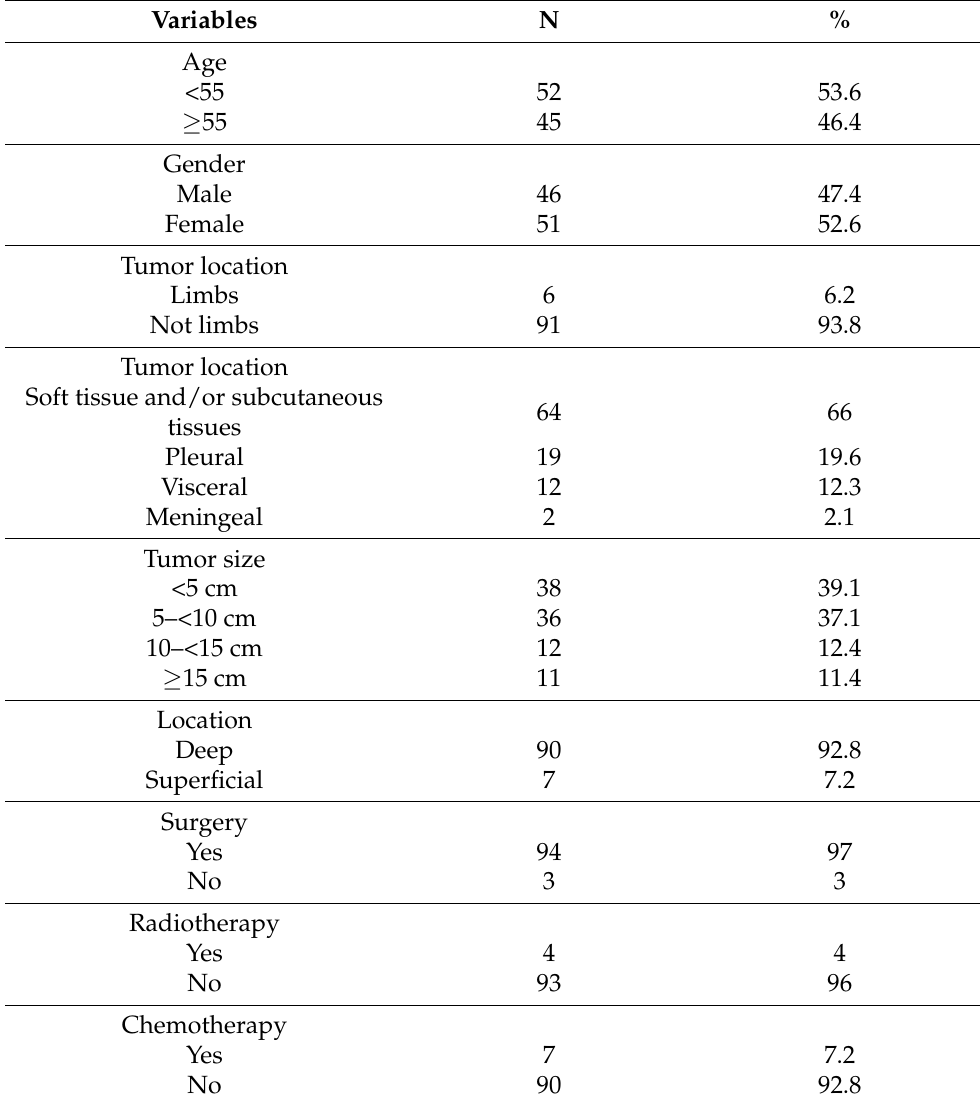
Table 1. Solitary fibrous tumor clinical data (N =